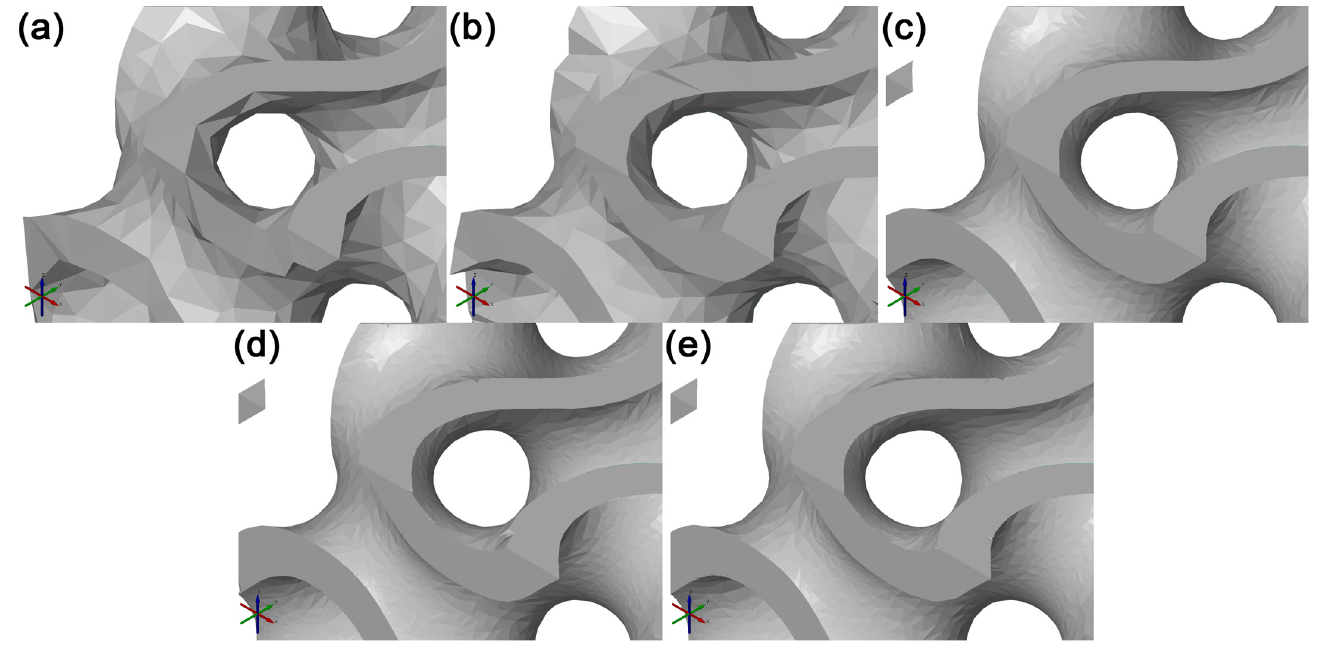
Figure 4. Illustration of the different surface qualities of tessellated cellular structure models of different accuracies, focusing on the boundary edges. ( a ) Model Very Low, ( b ) model Low, ( c ) model Medium, ( d ) model High, and ( e ) model Very High. Table 1. Table of values obtained from the comparison of cellular structure models of various accu- racies and the nominal CAD model in GOM Inspect.